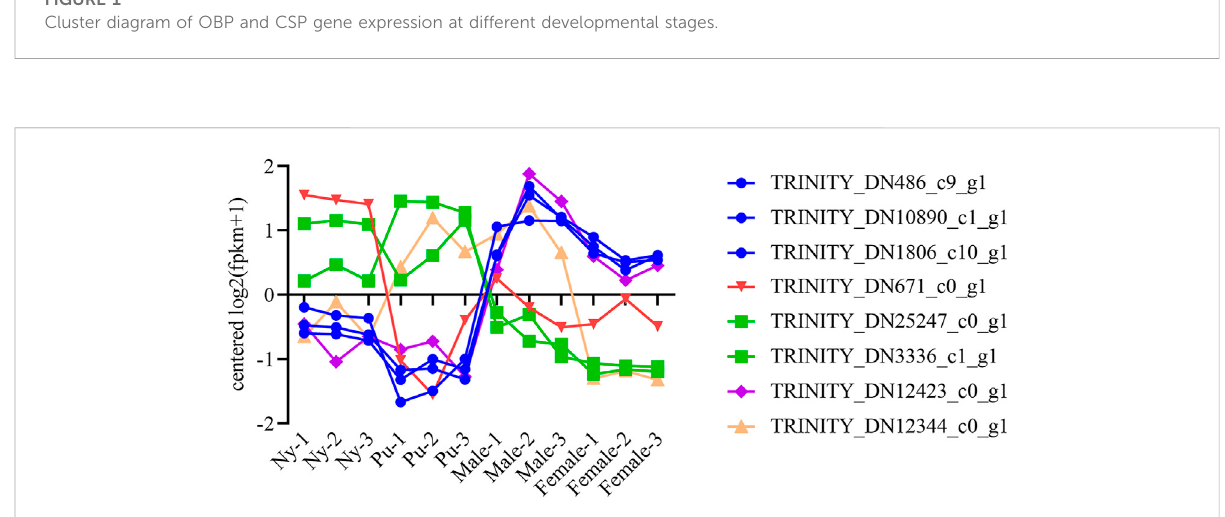
FIGURE 2 Trend analysis of OBP and CSP genes. Different colors distinguish different